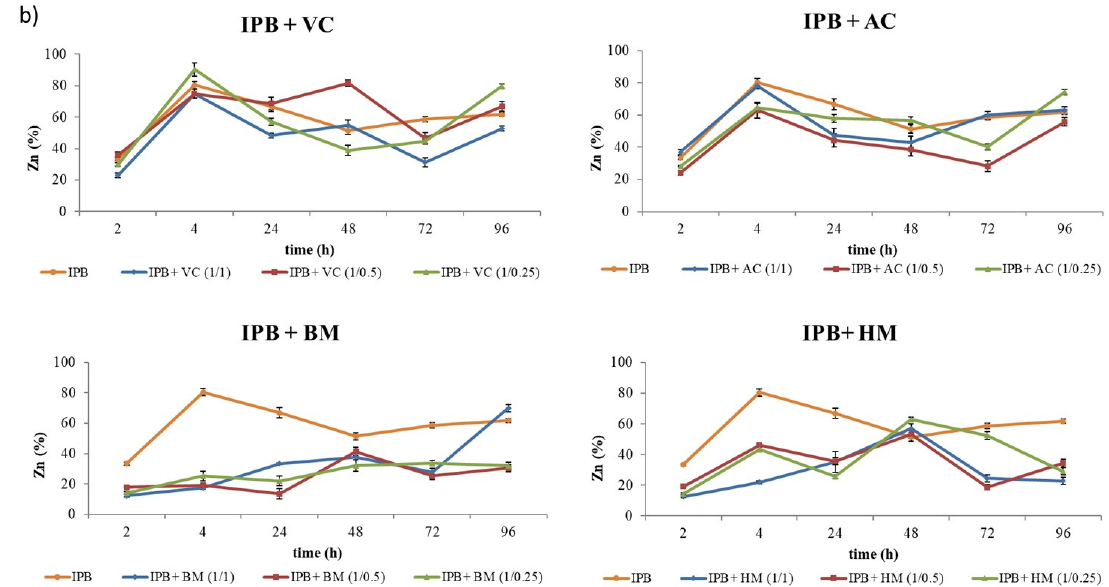
Figure 3. Evolution of Cu ( a ) and Zn ( b ) dissolved at different reaction times (h) .